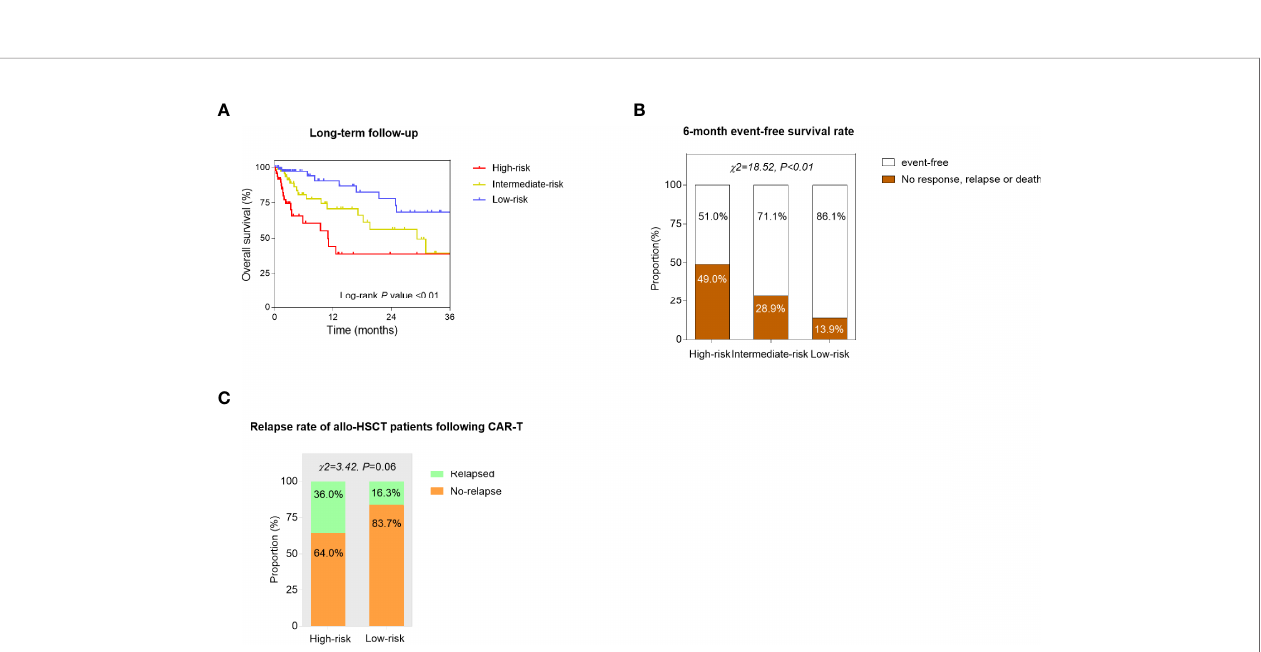
FIGURE 4 | Con fi rmation of the prognostic value of the constructed models. (A) Kaplan – Meier curves of the high-risk, intermediate-risk, and low-risk r/r B-ALL patients. The overall survival (OS) was compared by the log-rank test. (B) The 6-month event-free survival (EFS) rate was compared among high-risk, intermediate- risk, and low-risk groups using the chi-square ( c 2 ) test. (C) The relapse rate of the patients who received allogeneic hemopoietic stem cell transplantation (allo-HSCT) following CAR-T therapy was compared between high-risk and low-risk subgroups. p values were generated from the c 2 test.